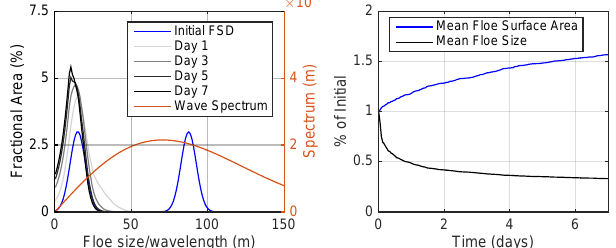
Figure 5. Results of simulations of the FSTD forced with swell fracture only. (a) The FSD before (black line, left axis) and af- ter (gray lines, left axis) several days of swell fracture using a Bretschneider (Michel, 1968, p. 23) wave spectrum (orange line, right axis). As swell fracture does not affect floe thickness, the dis- tribution is plotted as a function of floe size only. (b) The mean floe size and total lateral ice surface area as a fraction of their initial val- ues over the course of 1 week of ice fracture with the specified wave